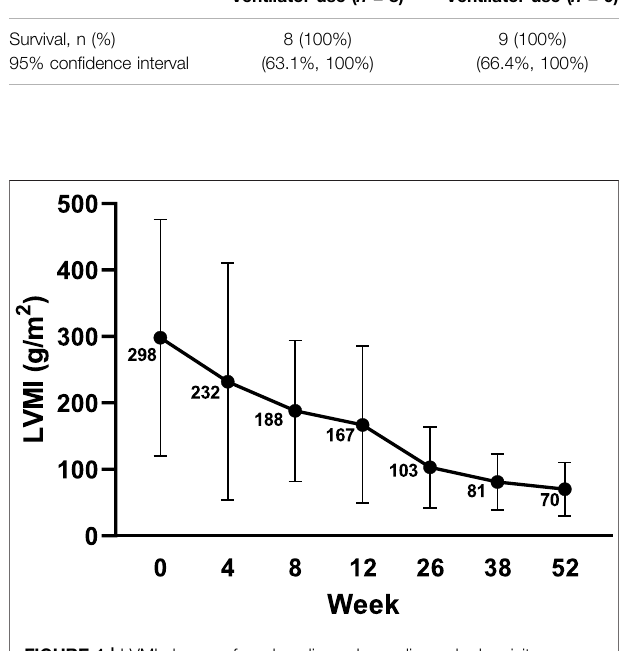
− 227.60 ± 155.99 g/m 2 ( Figure 1 ). The Z score of the LVM also improved gradually. The mean LVM Z score was 16.63 ± 5.17 at baseline and 4.30 ± 2.78 at week 52 ( Figure 2 ). Compared to 100% of subjects with LVM Z scores > 10 at baseline, eight subjects (80%) had LVM Z scores < 5, with one subject (10.0%) having an LVM Z score < 2 at week 52. Before she passed away, the LVM Z score of the subject who died decreased from 12.22 at baseline to 8.90 at week 8, suggesting the effect of the treatment.